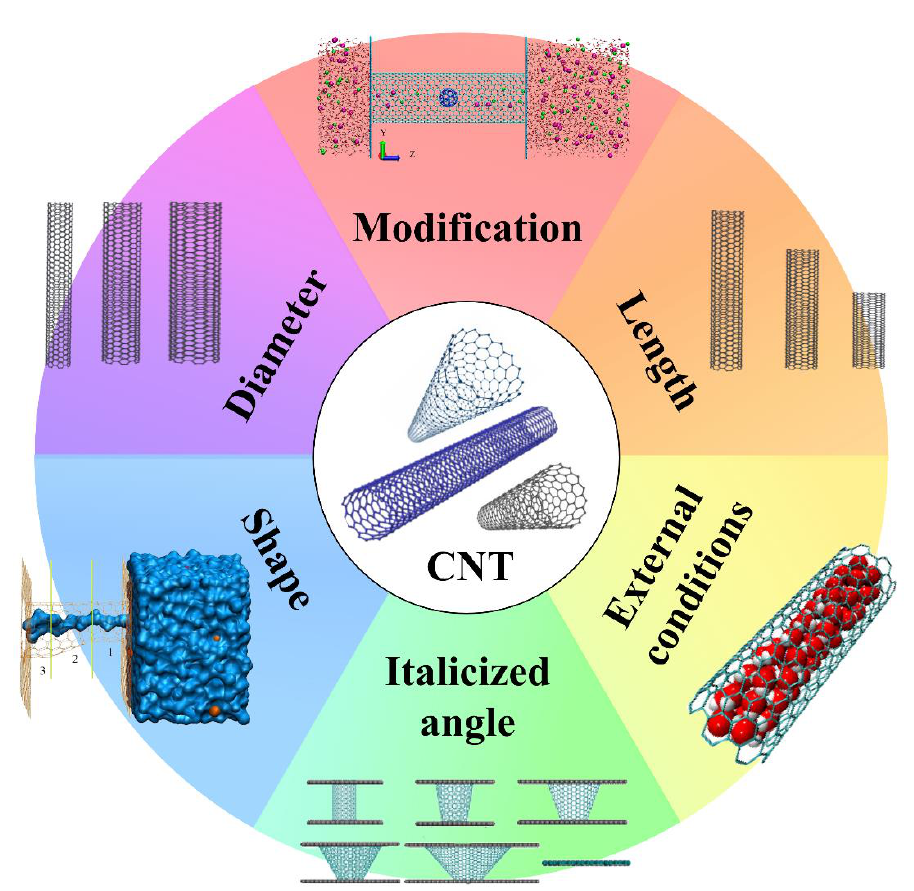
Figure 2. Some factors that affect the flow of water molecules in CNT channels (reproduced or adapted from ref. [35–38], with permission from Elsevier and American Chemical Society, 2017 and 2019).